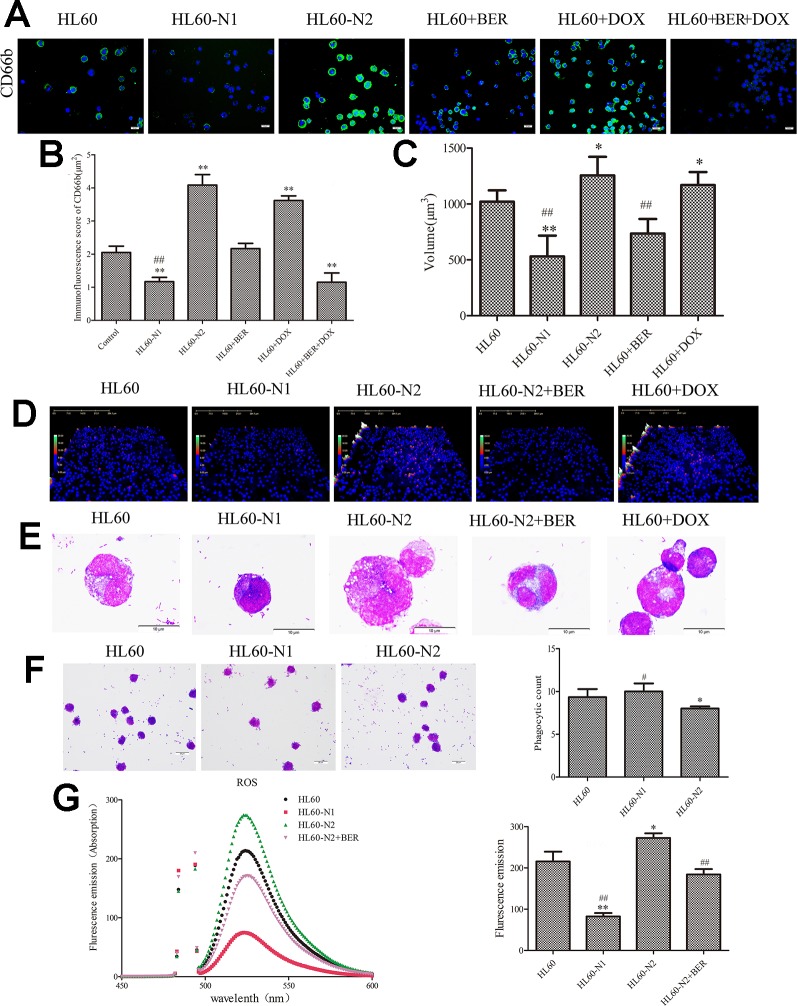
There is a difference between N1-like and N2-like neutrophils. N1-like and N2-like neutrophils were developed from the induced HL-60 cells. (A, B) Neutrophil CD66b expression was analyzed by fluorescein isothiocyanate (FITC)-conjugated anti-mouse CD66b staining (n = 5, 40×). (C, D) Neutrophil morphological changes analyzed by laser holographic cell imaging and analysis system (n = 5, 20×). (E) Neutrophil morphology indicated by Giemsa staining (n = 5, 100×). (F) Neutrophil phagocytosis detected by Giemsa staining (n = 5, 40×). (G) ROS detected by dichloro-dihydro-fluorescein diacetate (DCFH-DA) (n = 5). The data present mean ± SD, the experiments were repeated three times, and statistical significance was determined by a t-test. *P < 0.05, **P < 0.01 vs. HL60; #P < 0.05, ##P < 0.01 vs. HL60-N2. DOX, doxorubicin; BER, berberine.